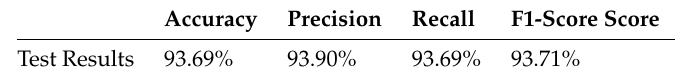
Table 17. Evaluation results of the model trained by LSTM network using filtered